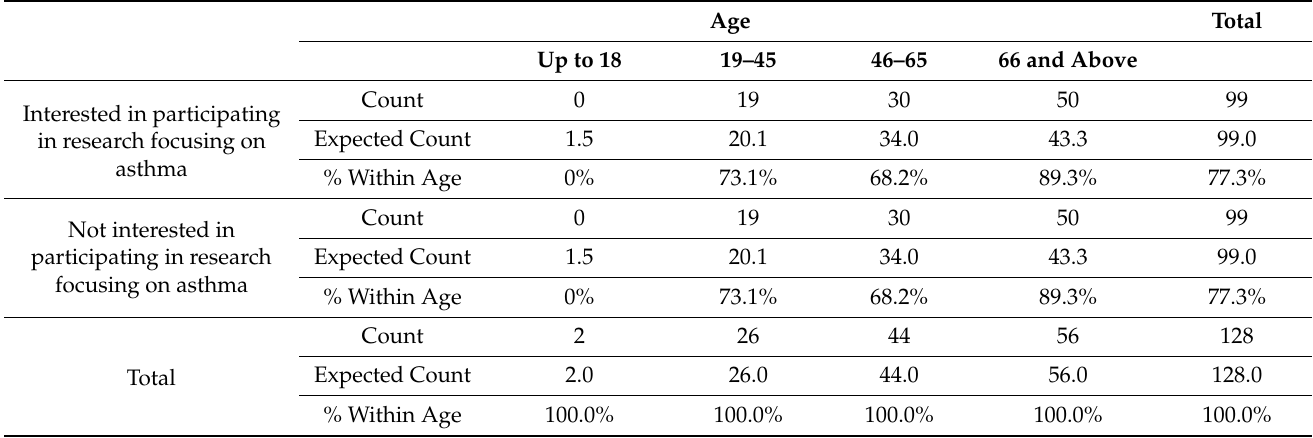
Table 7. Cross-tabulation results for research study focusing on asthma by age.